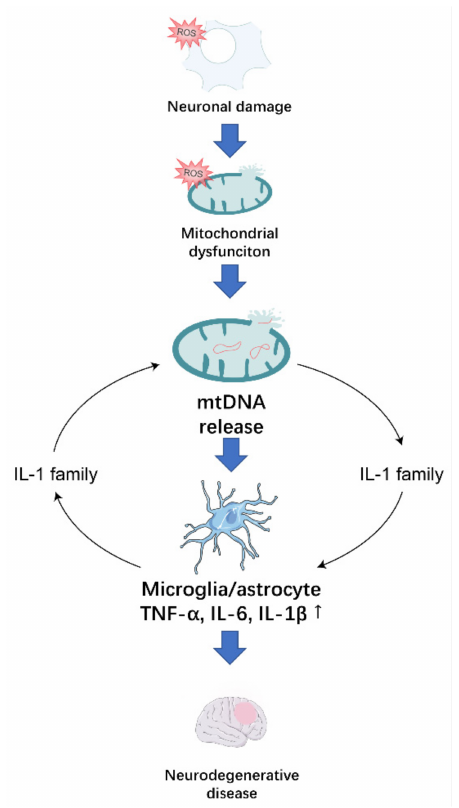
Figure 2. Oxidative stress in neurons induces oxidative stress in their mitochondria, leading to the release of the mtDNA, which stimulates the release of pro-inflammatory factors from surrounding microglia and astrocytes. The IL-1 family amplifies inflammatory signals in the neuroinflammatory microenvironment in which they are located, contributing to the development of neurodegenera- tive